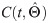
The best-fit cumulative number of cases obtained by fitting C(t,Θ^) (solid curve) in system (1) to the cumulative number of H1N1 cases (circle): The top panel for Model 1 and the bottom panel for Model 2.